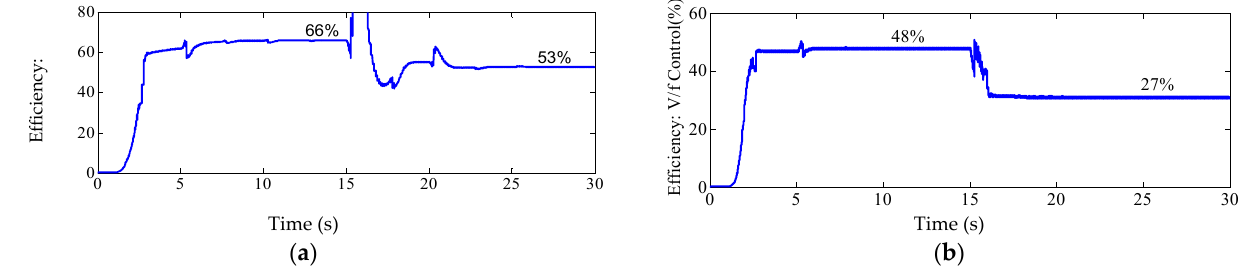
Figure 7 . Comparison of the efficiency of proposed drive with a regular v/f control drive in first scenario. ( a ) proposed method, ( b ) v/f control method